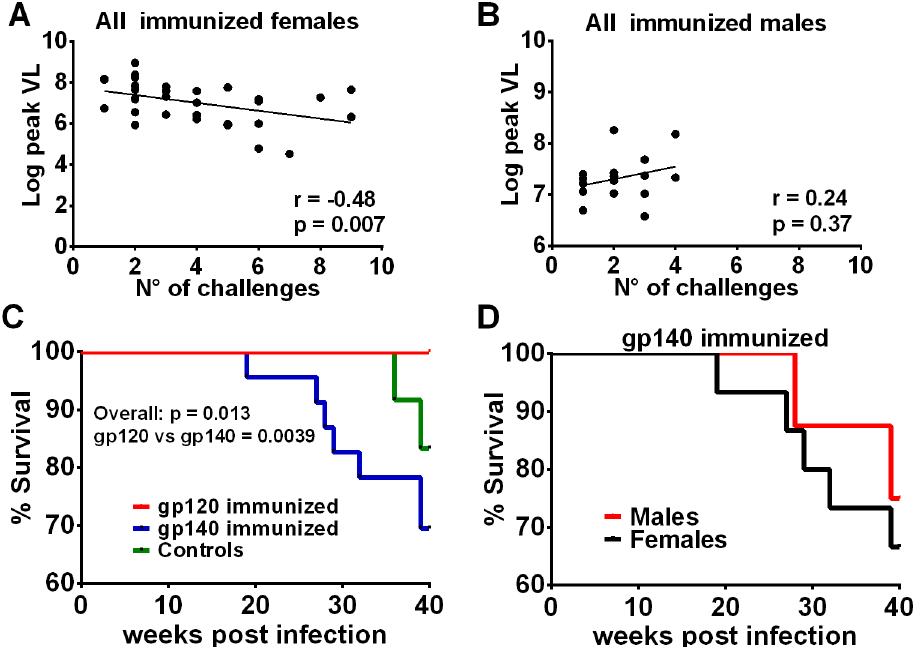
Fig 6. Additional post-infection outcomes by immunization group and sex. Correlation of the number of challenges required to become infected with peak viremia in all immunized females (A) but not in males (B). (C) Comparison of survival for gp120- and gp140-immunized macaques and control macaques. The overall p value was obtained by a logrank test. All 24 macaques in the gp120 immunization group survived at least 40 weeks, 7 of the 23 infected macaques in the gp140 group were euthanized between weeks 19 and 39, and 2 of 12 controls were euthanized between weeks 36 and 39. (D) Survival of female and male macaques in the gp140 group. Five of the 15 infected females were euthanized between weeks 19 and 39; 2 of 8 males were euthanized between weeks 28 and 39.